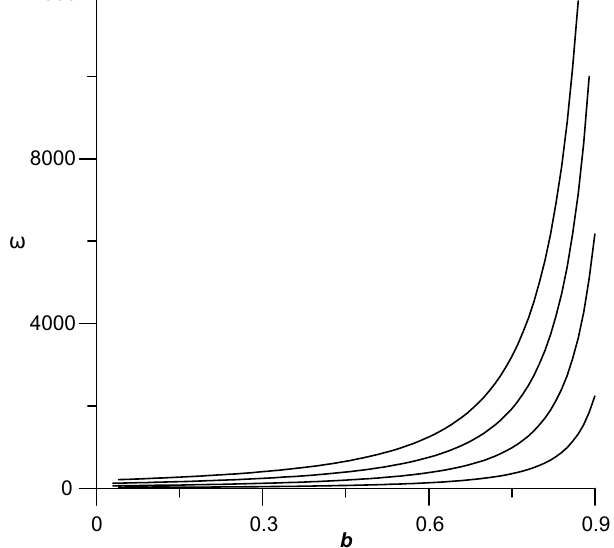
Fig. 1. Variation of the first four natural frequencies with the inner radius for a flat clamped-clamped